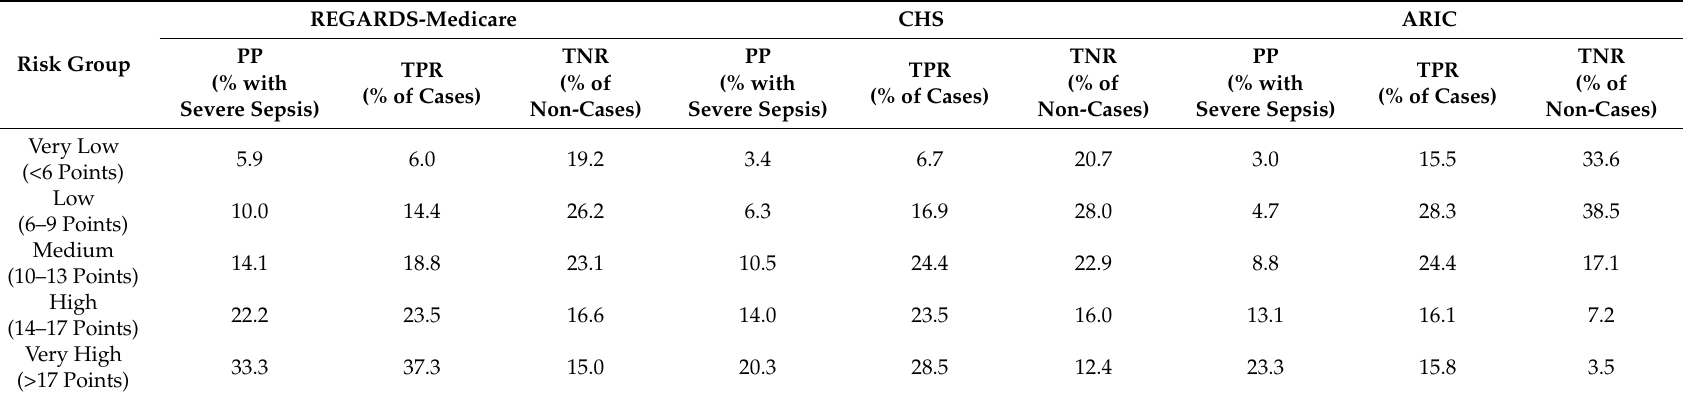
Table 5. Percentage positive with severe sepsis, true positive rate, and true negative rate by REGARDS-Severe Sepsis Risk Score risk